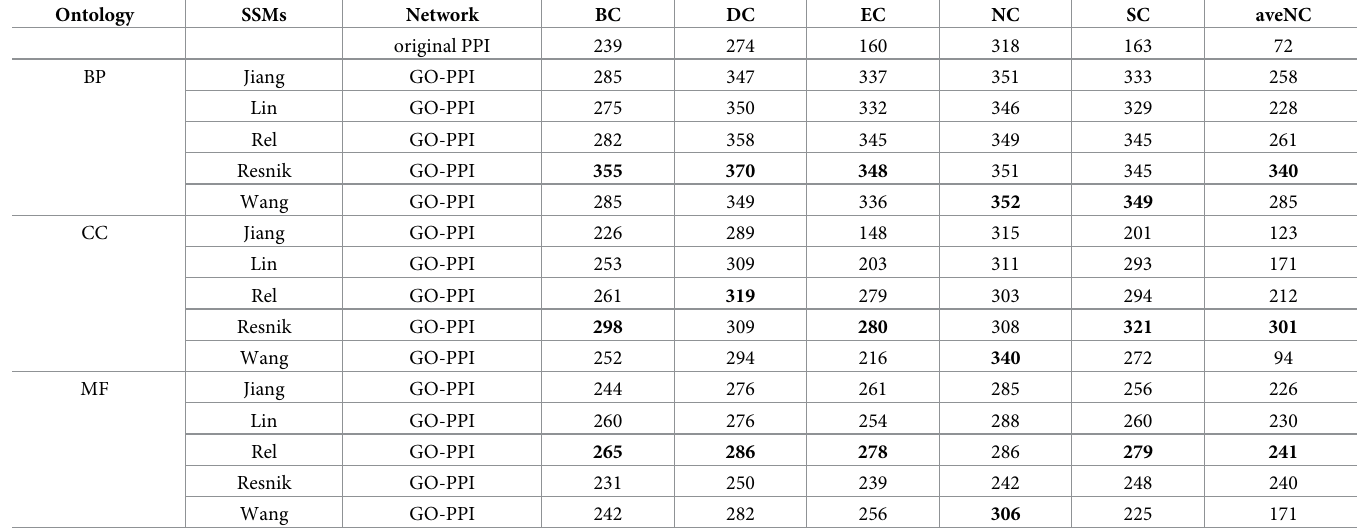
Table 5. The number of essential proteins detected by the six centrality methods under different strategies for the new DIP dataset (top 600). Ontology SSMs Network